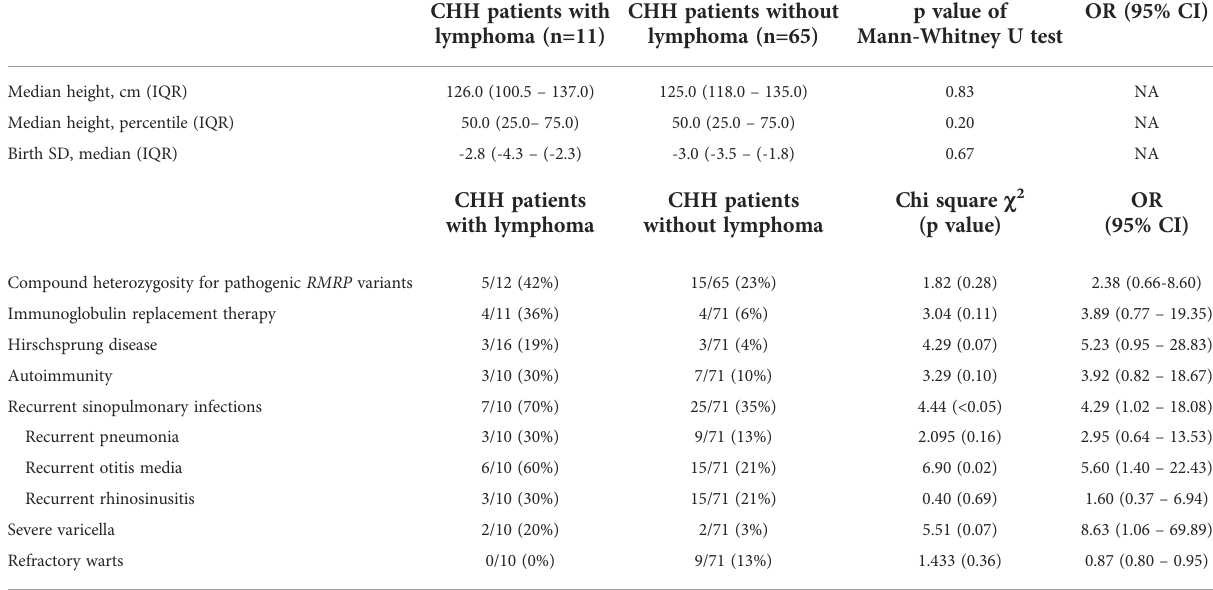
TABLE 4 Comparison of clinical characteristics in CHH patients with and without